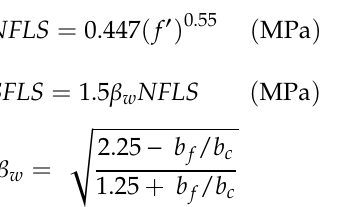
( b ) Figure 6. Delamination failure mode (E-30). ( a ) Experiment, ( b ) Analysis. 4.2. Failure Load and Load-Deflection Response The test results are summarized in Table 3. The initial crack loads for the A-100, M-50, E-50, E- 30 and LE-50 specimens were higher than the initial crack load for the C-0 specimen. The M-30 and LH-30 specimens were shown to be vulnerable to cracking, because the initial crack loads for the M-